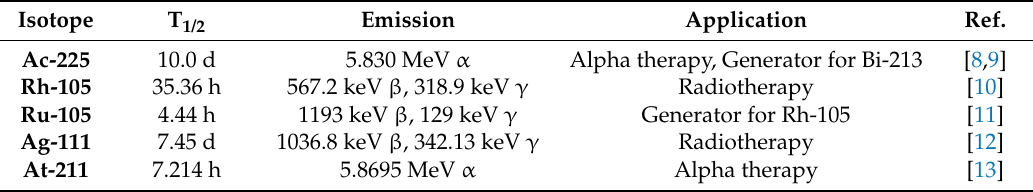
Table 1. Medical isotopes of interest coproduced during the proton irradiation of Thorium-232 (Th-232). Decay information from National Nuclear Data Center